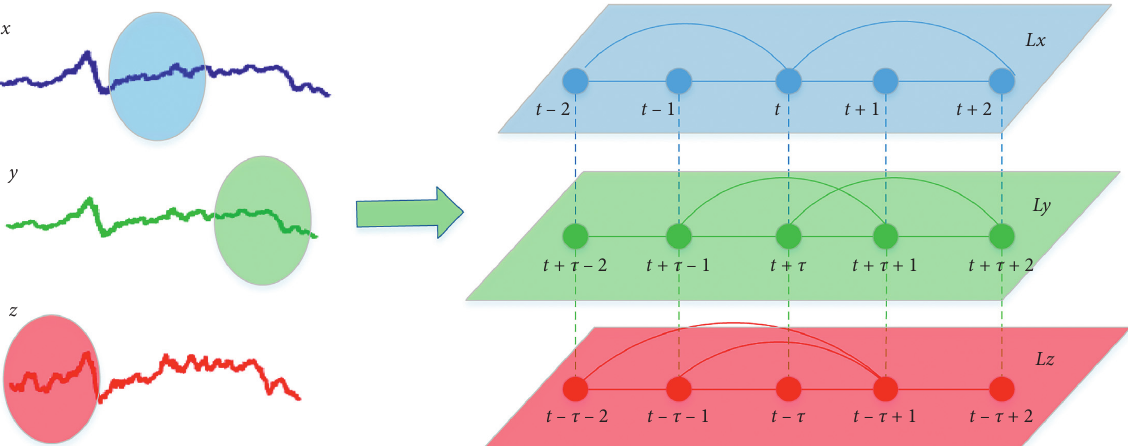
Figure 3: The time-delay multiplex recurrence network (DMRN) algorithm maps a three-dimensional time series into a three-layer time- delay